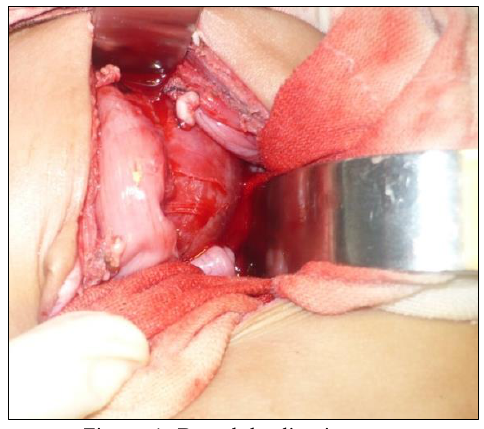
Figure 1: Rectal duplication